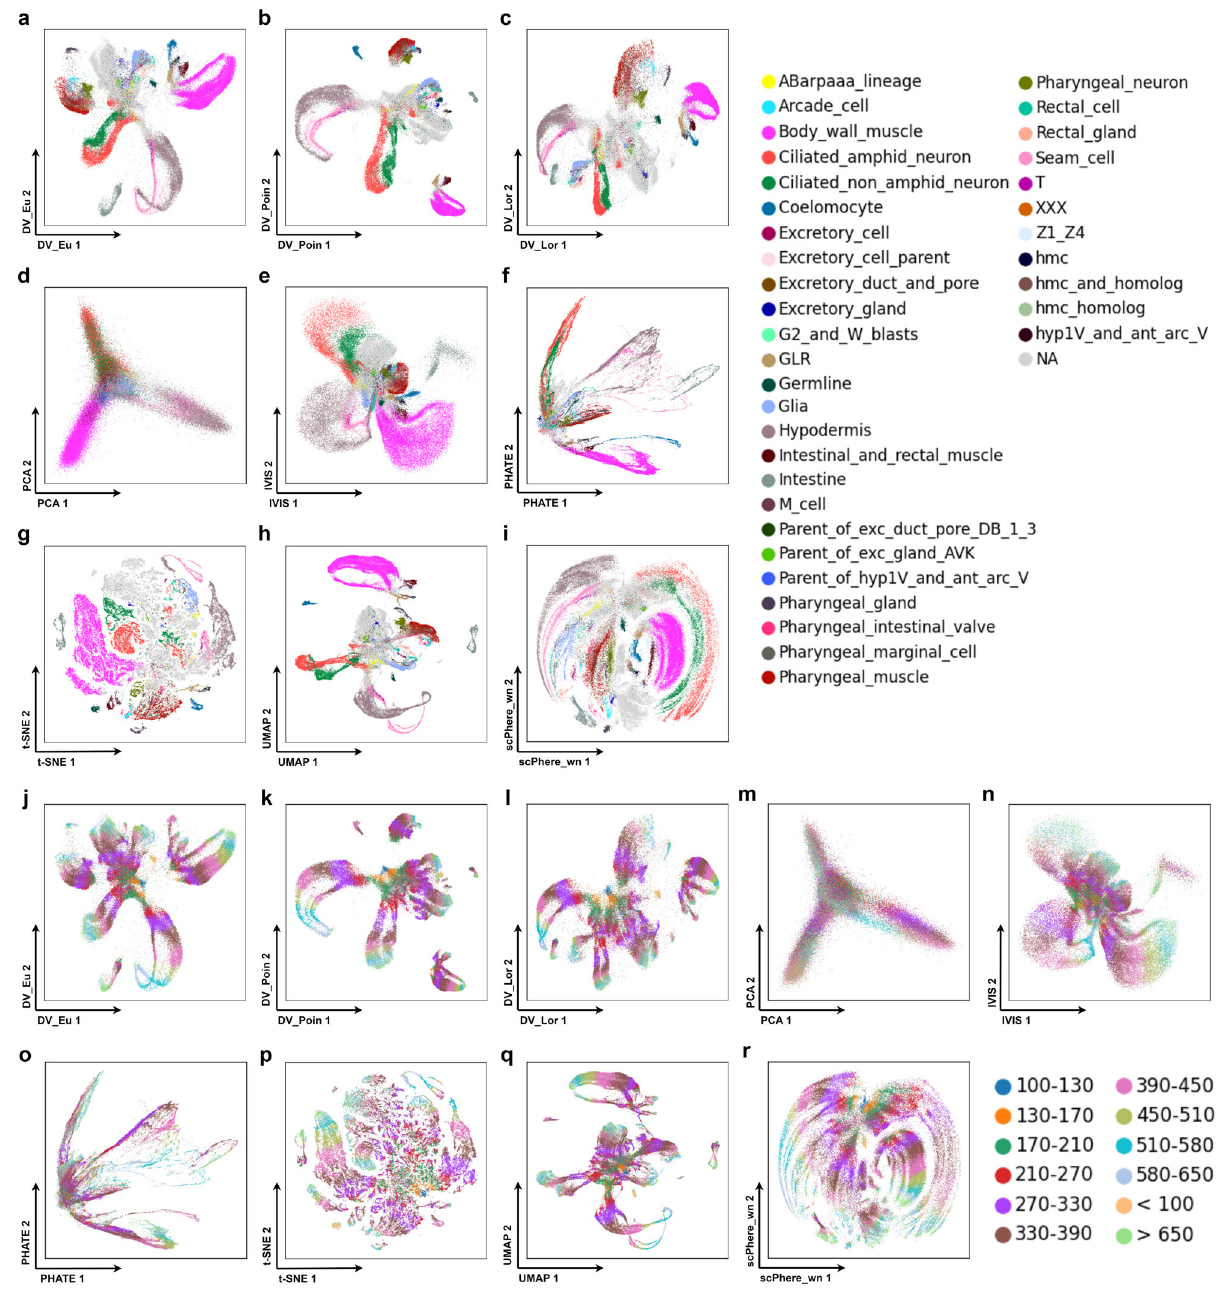
Fig. 3 DV shows developmental trajectories in visualizing large scRNA-seq dynamic data. DV_Eu learns representations in the Euclidean space ( a , j ). DV_Poin learns representations in the hyperbolic space with Poincaré model ( b , k ). DV_Lor learns representations in the hyperbolic space with Lorentz model ( c , l ). 2-dimensional PCA ( d , m ), IVIS ( e , n ), PHATE ( f , o ), t-SNE ( g , p ), UMAP ( h , q ) and scPhere_wn ( i , r ) representations for